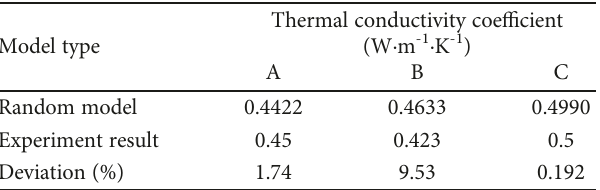
Figure 38: Pro fi le image of the heat fl ow vector of the fi nite element random model. Table 6: Comparison between random model and experimental